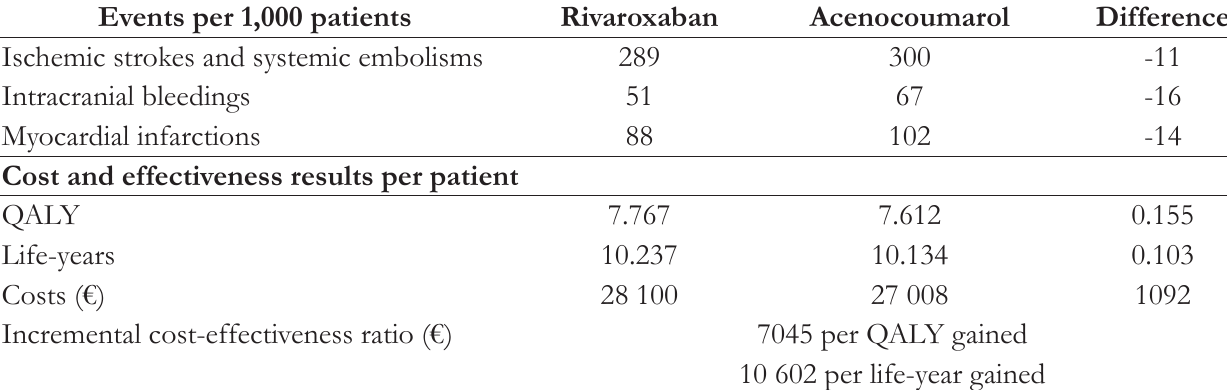
Table 5. Cost-effectiveness Results and Events avoided over the Life-time of